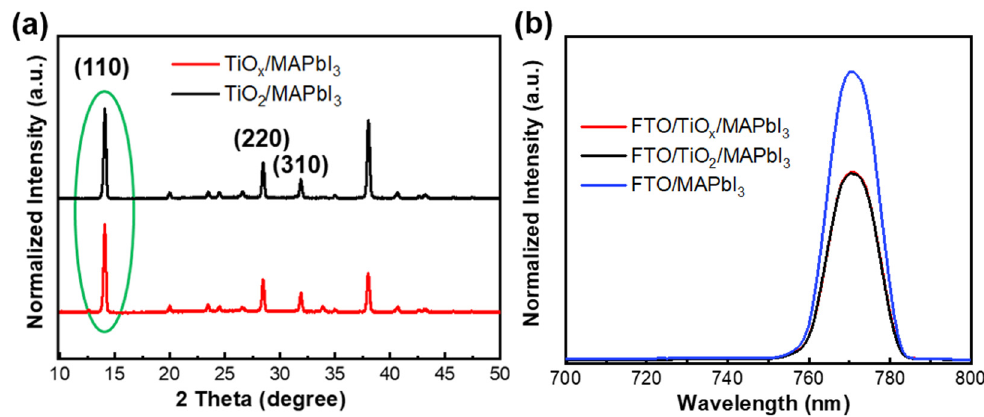
Figure 4. ( a ) XRD pattern of the perovskites formed on the TiO x and TiO 2 films, and ( b ) photoluminescence (PL) spectra of the perovskites formed on the FTO substrate, FTO / TiO x film, and FTO / TiO 2 film.